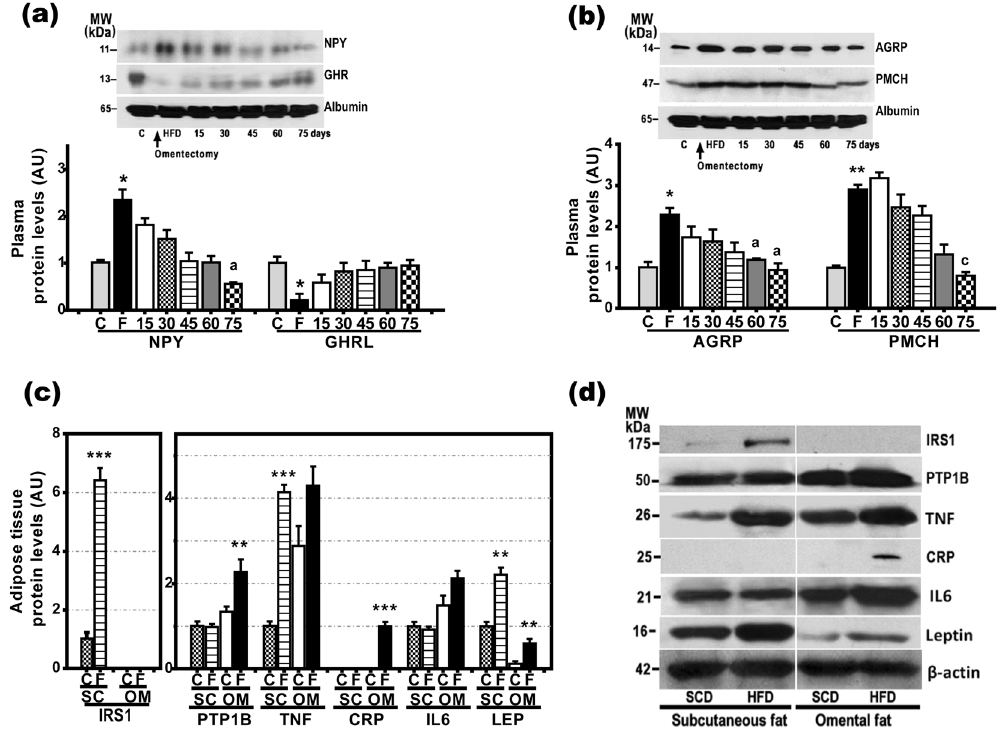
Figure 6. Protein expression of IRS1, leptin (LEP), IL-6, CRP, TNF- α , PTP1B, and insulin (INS) in subcutaneous and omental fat and evolution of plasma levels for orexigenic factors after omentectomy. ( a , b ) Evolution of plasma levels of orexigenic factors after omentectomy at the age of 14 weeks in HFD-fed rats (HFD/O2 rats). Bar graphs illustrating protein expression are shown at the bottom of the figures. * p < 0.05; ** p < 0.01 vs . SCD-rats. a p < 0.05; c p < 0.001 vs . HFD-rats. ( c , d ) Protein expression of IRS1, PTP1B, TNF- α , CRP, IL6, leptin, and β -actin in the subcutaneous and omental fat of SCD-rats and HFD-rats. Results are given as mean ± S.D., Protein expression in subcutaneous fat of rats on a standard chow diet was assumed to be 1. ** p < 0.01 *** p < 0.001 vs .